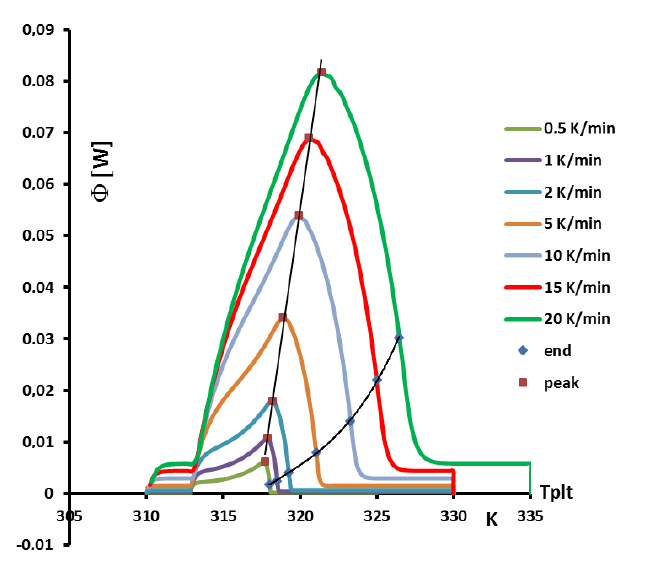
Figure 30. Determination of T liquidus the temperature of the liquidus for x 0 = 0.8; from [16].